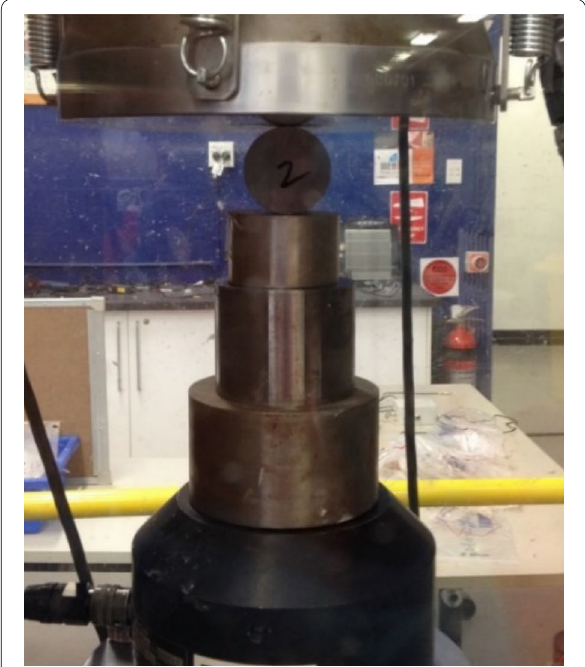
Fig. 4 Split tensile strength test.